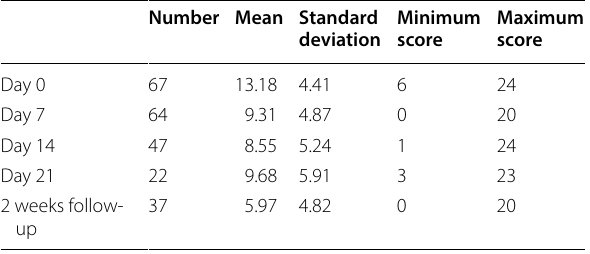
Table 2 Mean depression score according to the quick inventory of depressive symptomatology (QIDS)